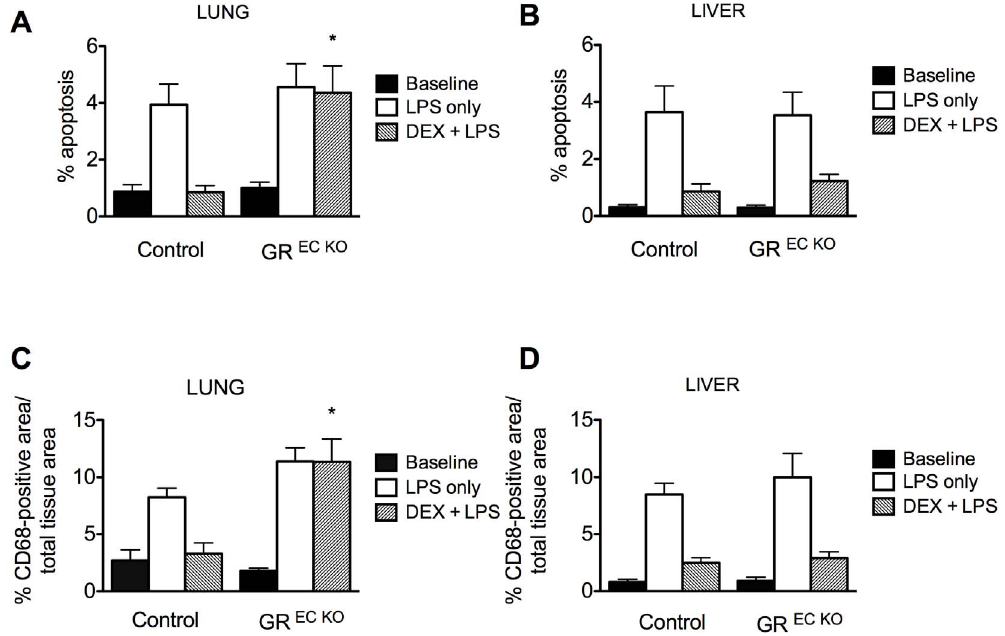
Figure 3. Lung apopotosis (A) and macrophage infiltration (C) are not improved by DEX in GR EC KO mice. Both GR EC KO mice and controls show an improvement in liver apoptosis (B) and macrophage infiltration (D) following DEX. *p , 0.05 compared to similarly treated controls.